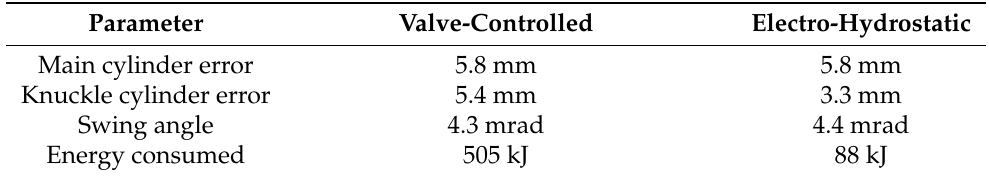
Table 8. Performance comparison between valve-controlled system and electro-hydrostatic